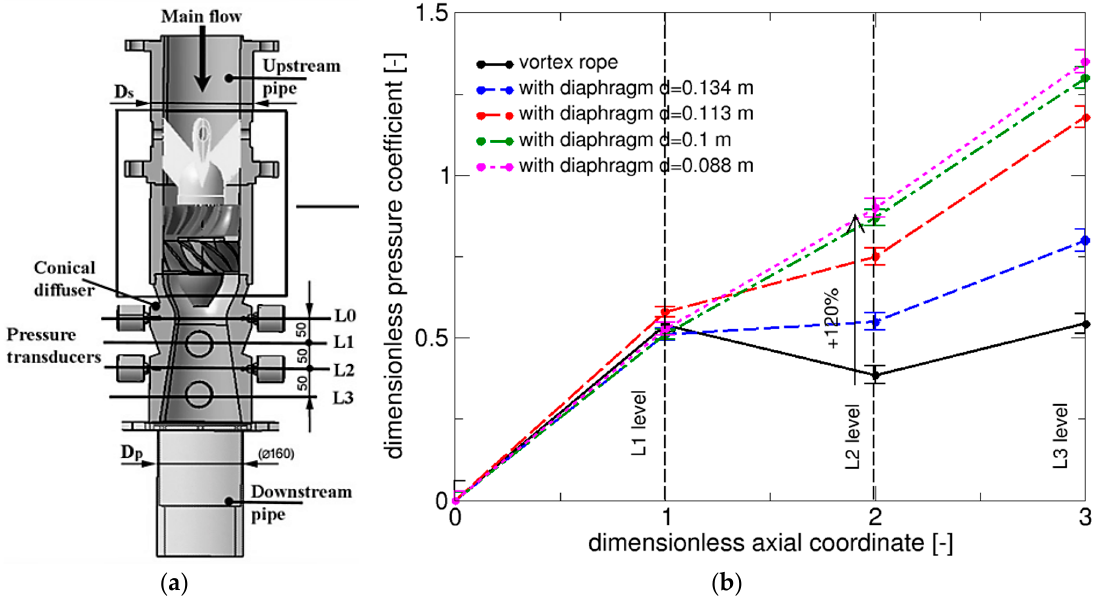
Figure 3. Detail of test section and swirl generator ( a ). Pressure coefficient measured on the cone wall for swirling flow with vortex rope (solid line) and the cases with diaphragm method ( b ).